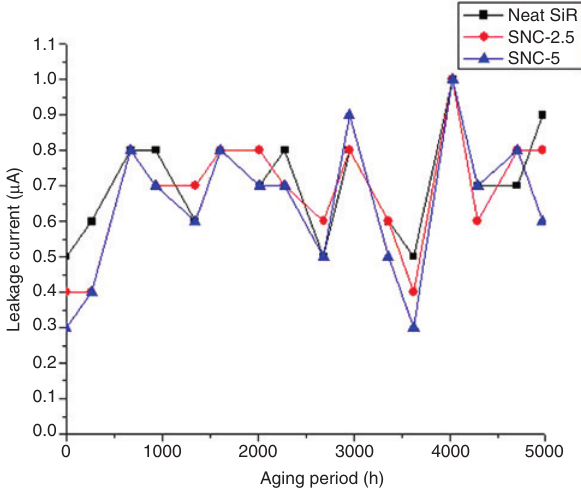
Figure 7: LC variation in neat SiR, SNC-2.5, and SNC-5 with aging.